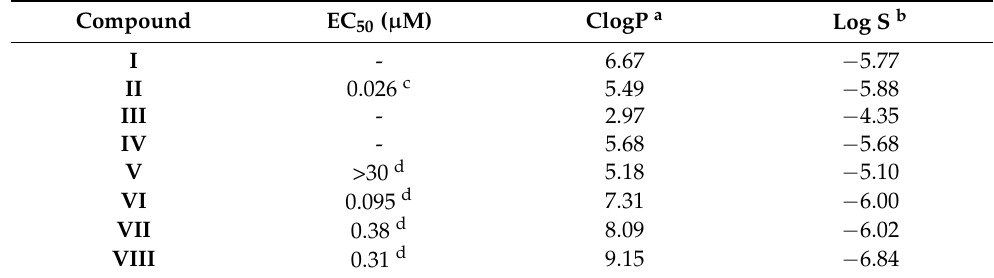
Table 1. Reported EC 50 and calculated lipophilic and solubility parameters for compounds I – VIII . Compound EC 50 ( µ